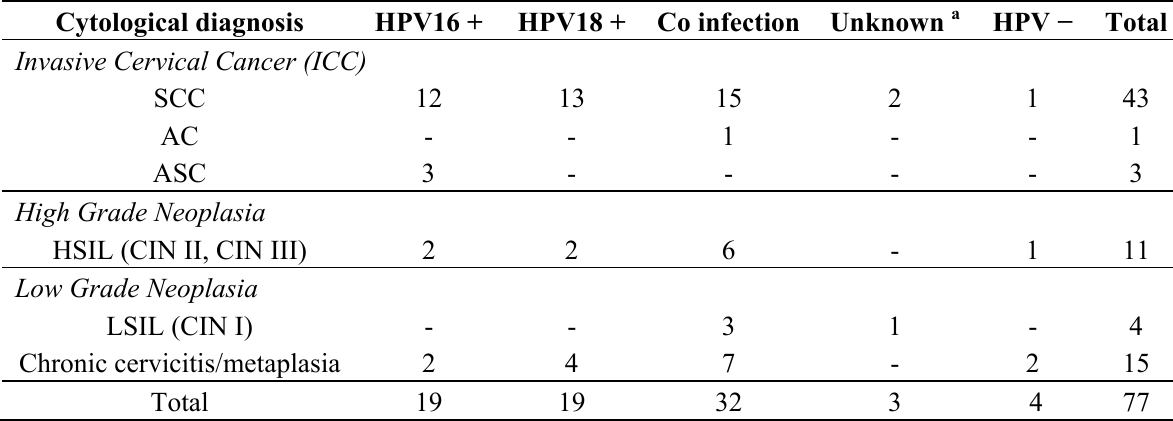
Table 3. Histopathological classification and HPV status of cervical cancer biopsies SCC; Squamous cell carcinoma, AC; Adenocarcinoma, ASC; Adenosquamous carcinoma, HSIL; High grade intraepithelial lesion, LSIL; Low grade intraepithelial lesion, CIN; Cervical intraepithelial neoplasia. a Samples that were HPV positive (GP5+/GP6+), but genotype was not